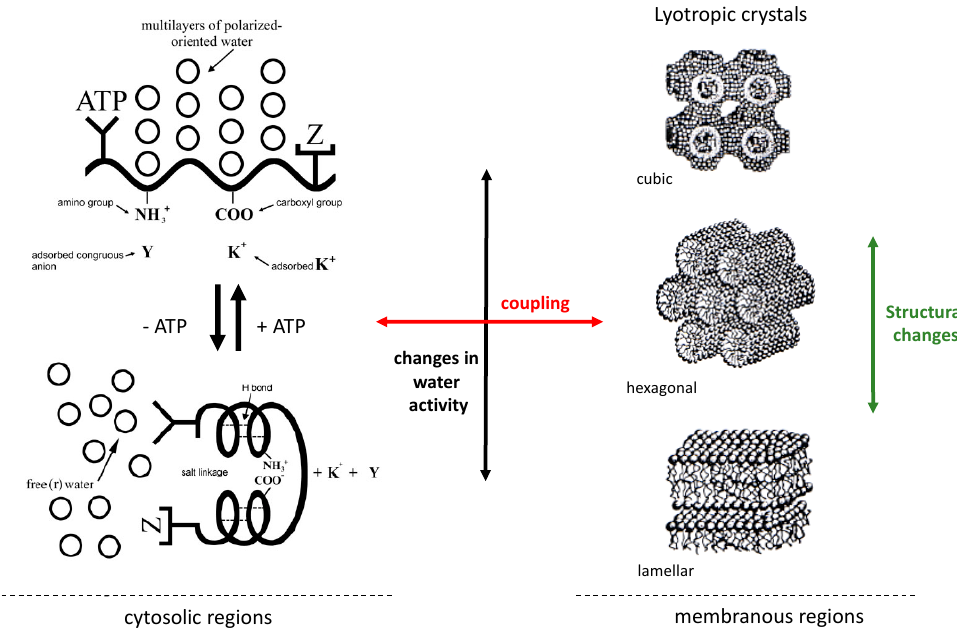
Figure 4. Sketch of the coupling between cytosolic and membranous regions. Changes in the activity of water caused by the polarization of intracellular water—via metabolic e ff ects—can induce lyotropic regulation of the membrane structure with, for example, important curvature e ff ects. For more details, see Section 4. Part of the figure is adapted from